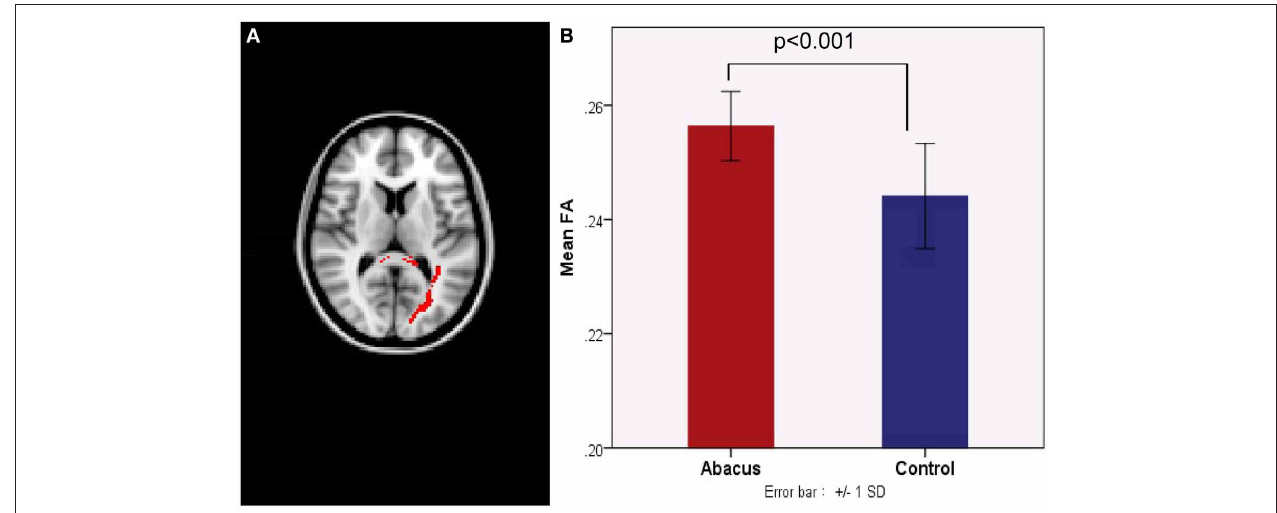
FIGURE 3 | (A) A new tract projection pathway, such as left forceps major pathway, was formed from left FG to other brain regions in the abacus-trained group. This tract pathway was extracted as white matter